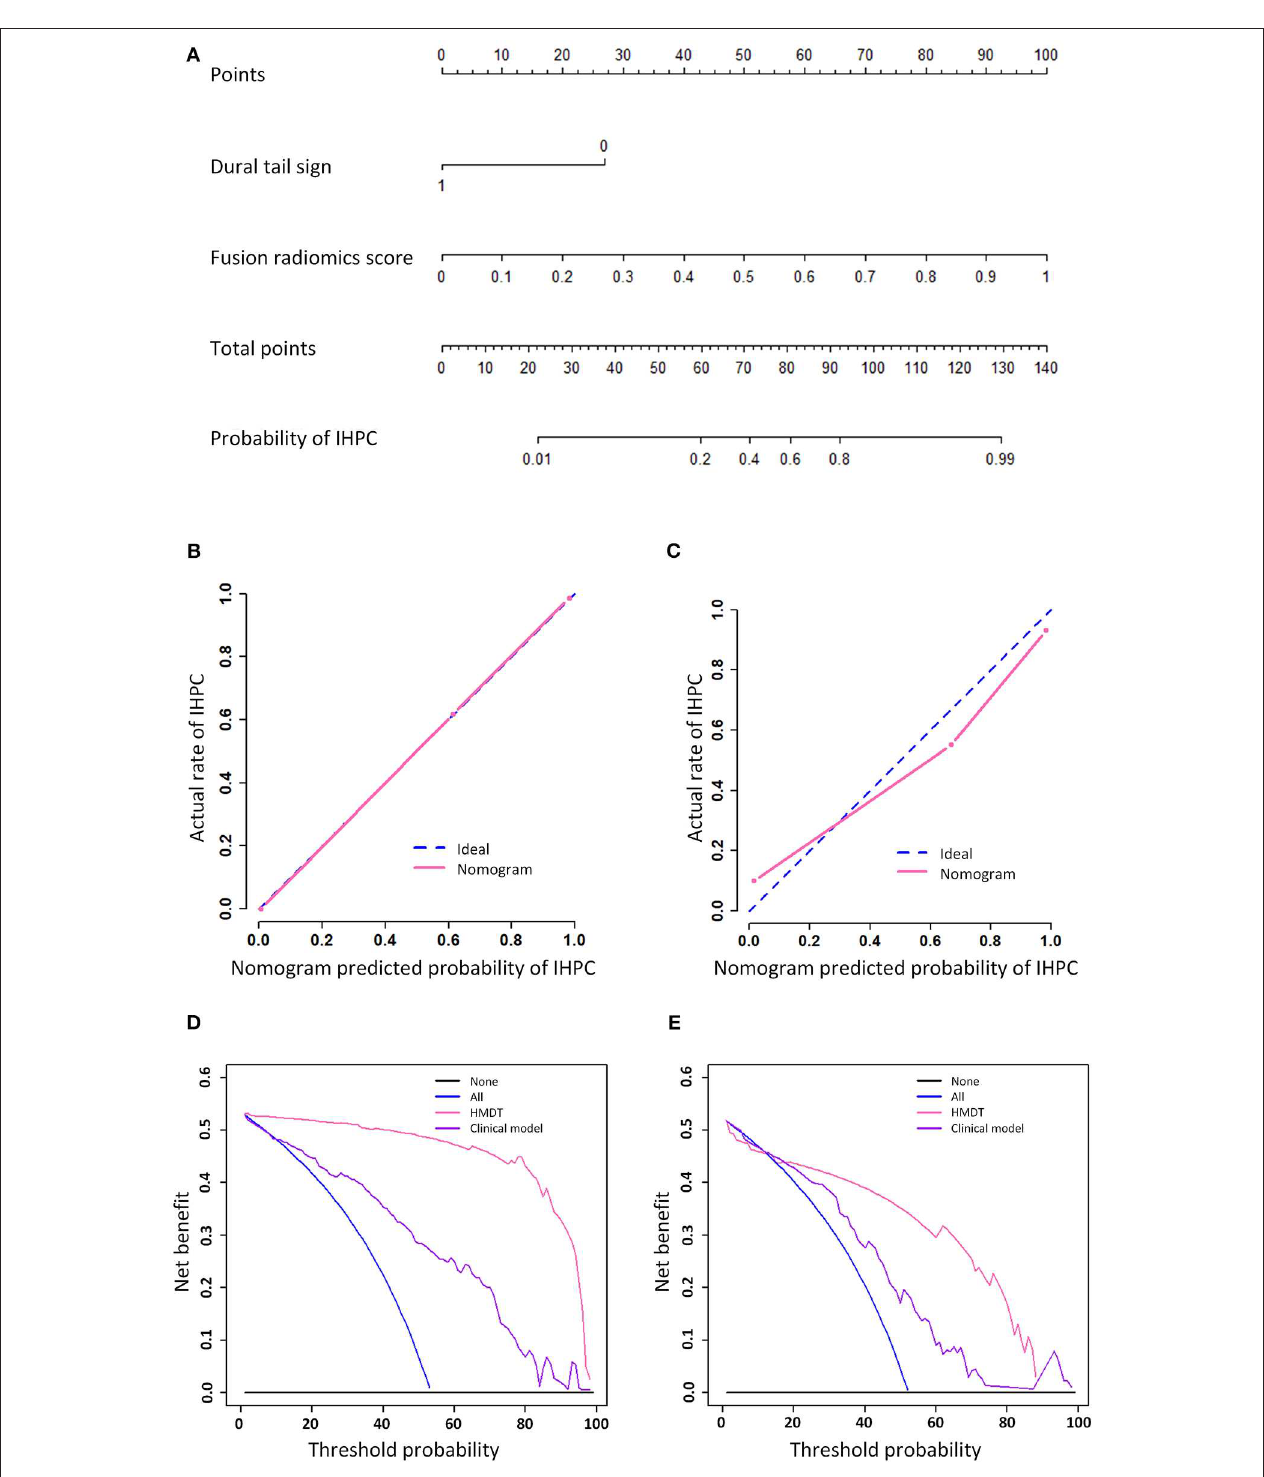
FIGURE 3 | Nomogram, calibration curve, and decision analysis curve. The nomogram that showed a linear presentation of the HMDT was shown in (A) . The calibration curves in training and validation cohorts were shown in (B,C) , respectively. Decision analysis curves in the training and validation cohorts were shown in (D,E) . The y-axis represents the net benefit and the x-axis represents the threshold probability.